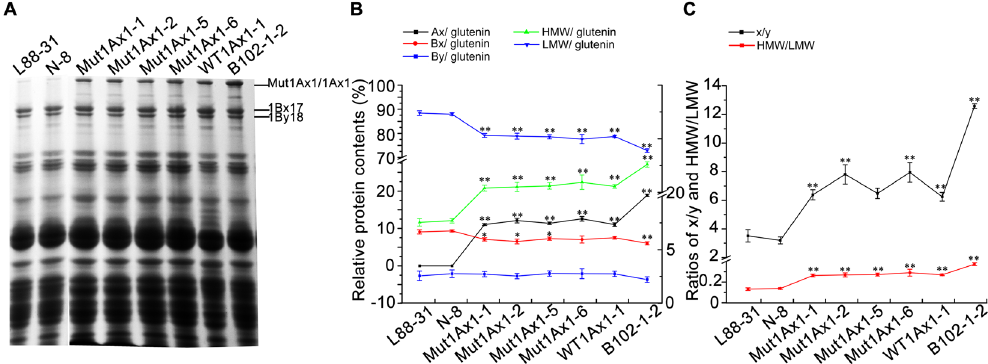
Figure 2. Characterisations of glutenin proteins in transgenic and control lines. ( A ) SDS-PAGE of seed proteins extracted from transgenic and control wheat lines. Transgenic Mut1Ax1 and endogenous subunit pair 1Bx17 + 1By18 were indicated by short lines on the right side of the gel. ( B ) The amounts and proportions of HMW-GS and LMW-GS and the ratios of x/y and HMW/LMW were determined by densitometry analysis for all lines. Data are given as the mean ± SEM (n = 4). * and ** show the comparisons between all transgenic lines and negative controls (L88-31 and N-8) ( * P < 0.05, ** P < 0.01 by Student’s